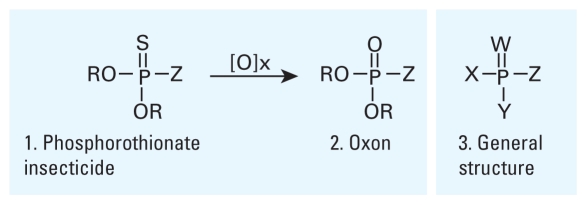
Structure of OP insecticides and select OP agents. Abbreviations: Et, ethyl; Me, methyl; Ph, phenyl. For malathion, R = Me, Z = SCH(CO2Et)CH2CO2Et; parathion, R = Et, Z = O–Ph–p–NO2; chlorpyrifos, R = Et, Z = o-2,3,5-trichloropyridinol; azinphos, R = Et, Z = SCH2–3-benzenetriazole-4-one; diazinon, R = Et, Z = O[6-Me, 4-iPr-pyrimidinol]. Parathion, chlorpyrifos, azinphos, and diazinon are also available as dimethyl esters.